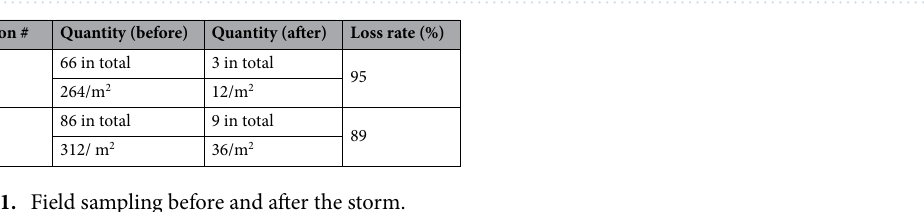
Table 1. Field sampling before and after the storm.